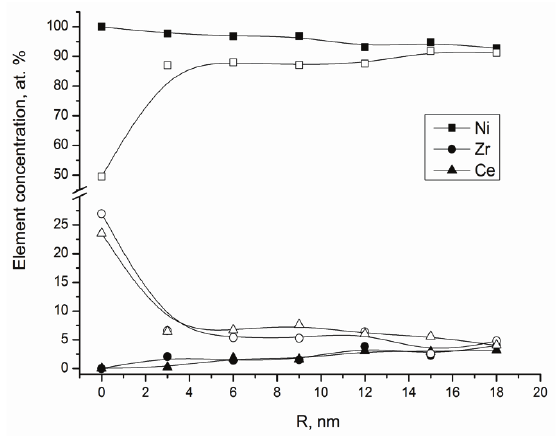
Figure 4: TEM images of calcined under air Ni/Ce-Zr catalysts: A - Ni/B1, B - Ni/Ch, C - Ni/B2. Investigation of samples Ni/Ch and Ni/B2 after the reducing treatment showed that the average size of Ni particles was close to that of NiO (Table 2). Furthermore, Ni particles in Ni/Ch were flattened, suggesting their stronger interaction with the support. The analysis of the interplanar distances in TEM images revealed the core-shell structure of Ni-containing particles consisting of the metal core and NiO shell. For sample Ni/B2, the surface of some Ni particles is covered by Ce-Zr-O layers (Figure 5B). Figure 5: TEM images of Ni/Ce-Zr catalysts aft er reduction treatment: A - Ni/Ch, B - Ni/B2.